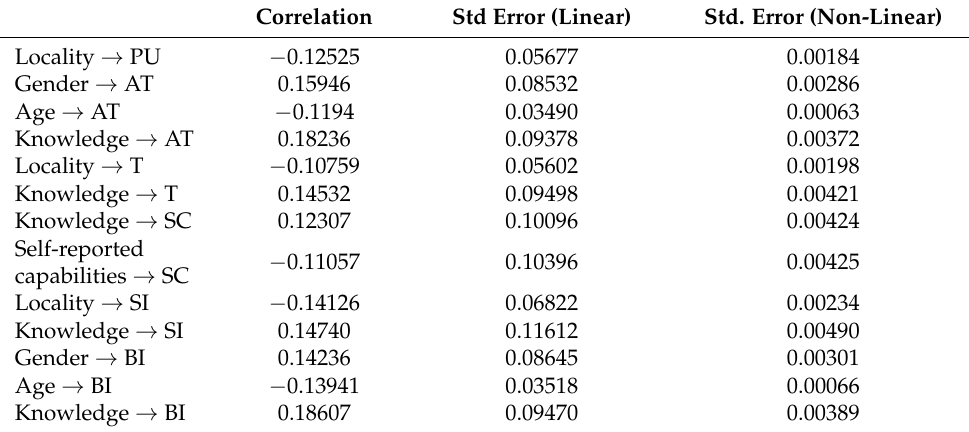
Table 16. Personal characteristics variable